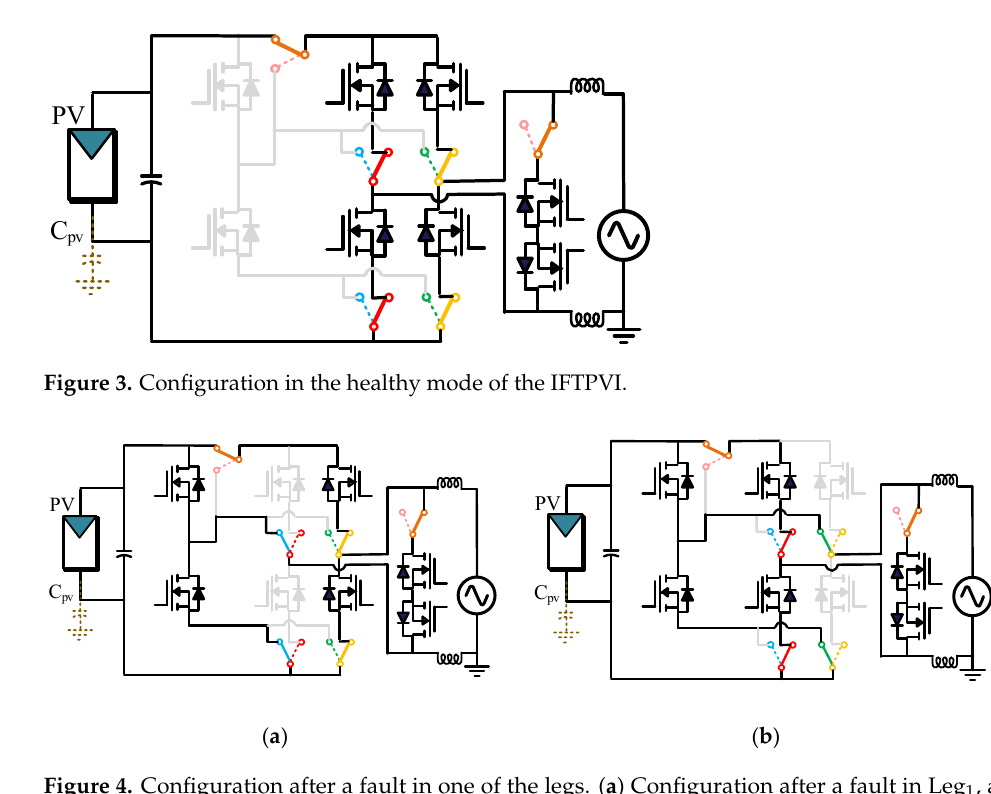
Figure 4. Configuration after a fault in one of the legs. ( a ) Configuration after a fault in Leg 1 , and ( b ) configuration after a fault in Leg 2 .